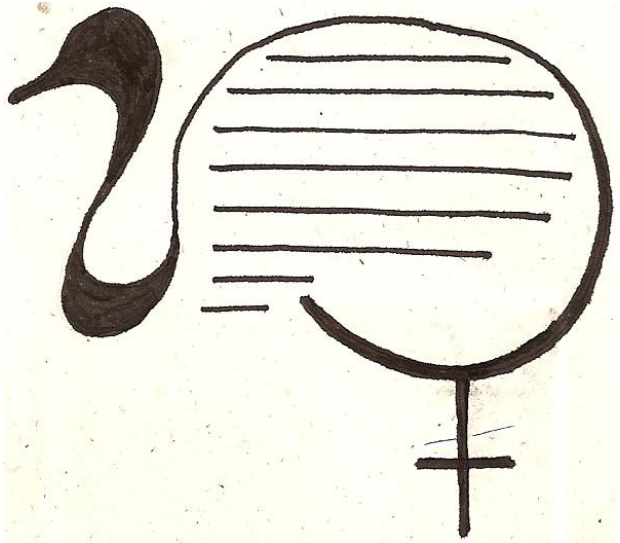
Figure 3. The sketch of Gabbie‘s tattoo that hung in her dorm apartment at Blair Mill